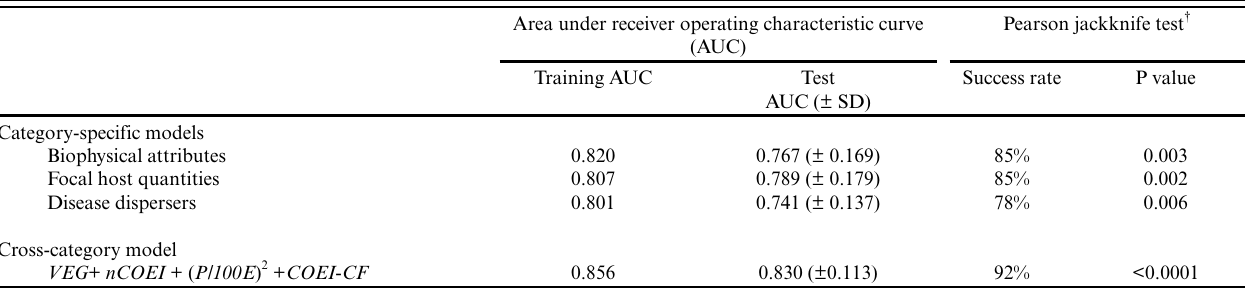
Table 3 . Model performance and goodness-of-fit results for category-specific and a cross-category composite model examining ecological predictors of Avian Cholera outbreak probability at Common Eider ( Somateria mollissima ) breeding colonies.